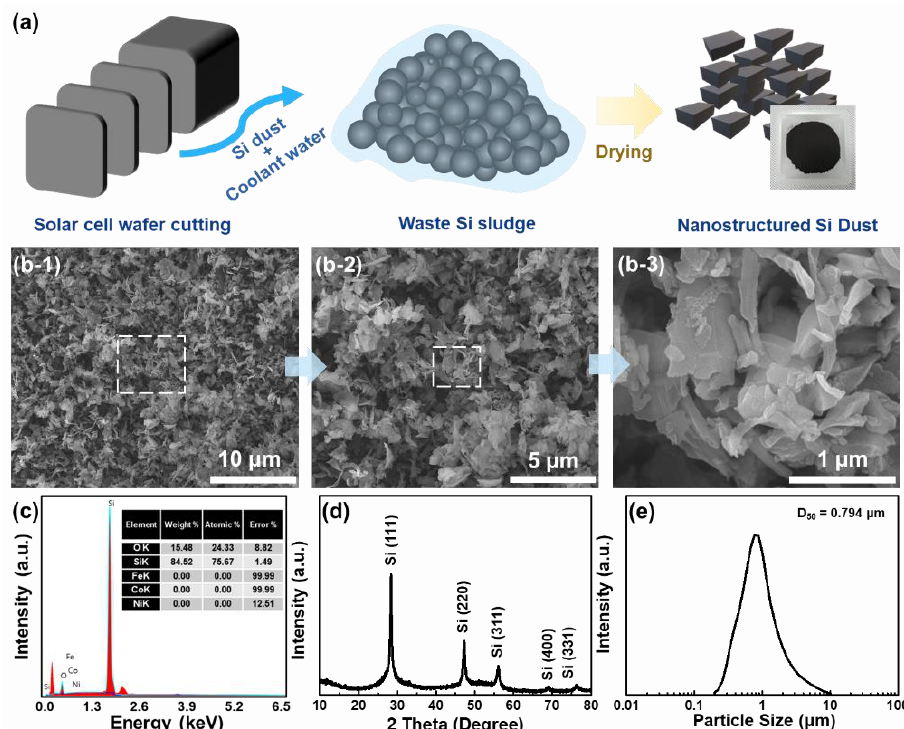
Figure 1. ( a ) Schematic illustration of yielding process of NSD, ( b1 – b3 ) scanning electron microscopy (SEM) images of NSD, ( c ) energy dispersive X-ray spectroscopy (EDX) results of NSD, ( d ) X-ray diffraction (XRD) pattern and ( e ) particle size distribution (PSD) of NSD.